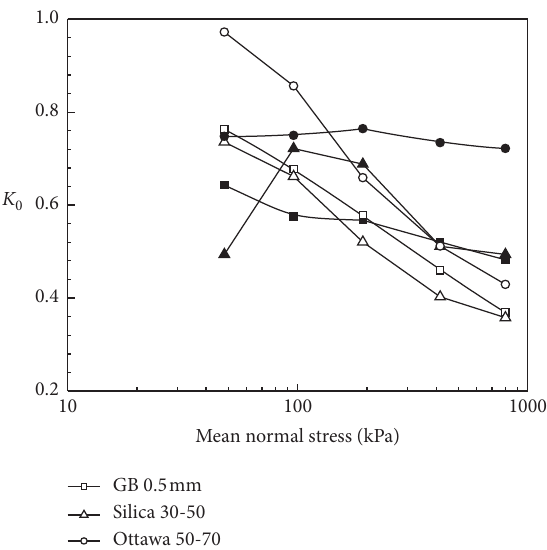
Figure 7: Comparison between the fitted K tested K 0 (solid symbols are the estimated K 0 and hollow symbols are the direct measured K 0 ).